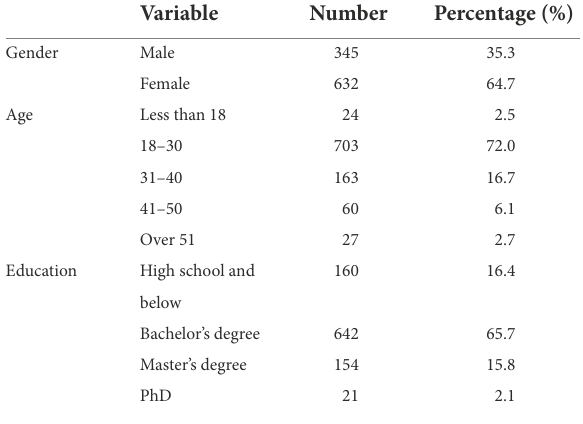
TABLE 2 Demographic statistics of the respondents ( n =